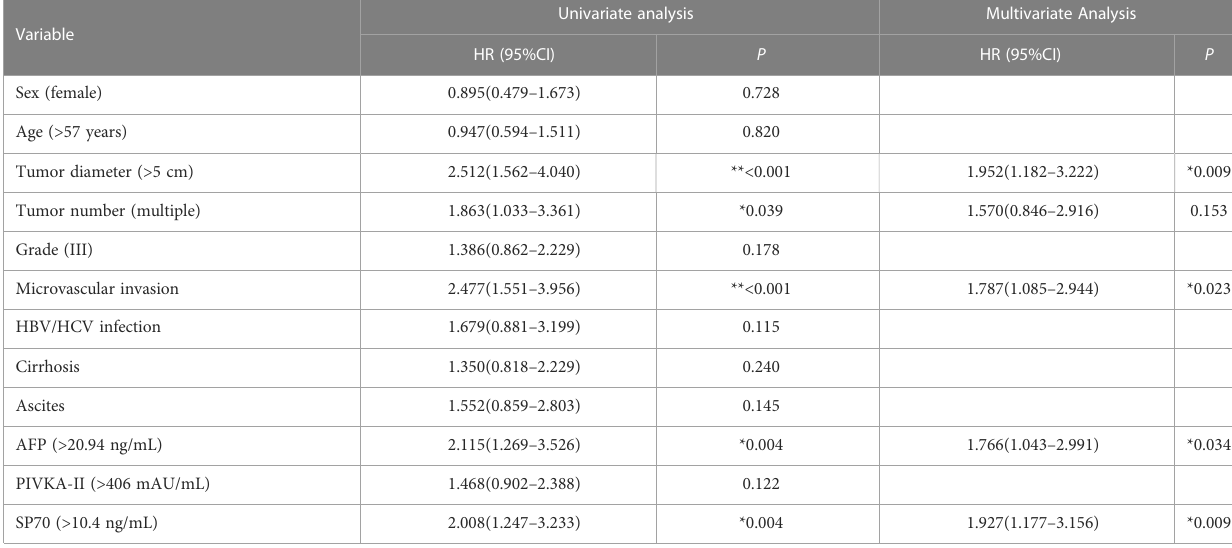
TABLE 4 Univariate and multivariate analysis of risk factors predicting recurrence-free survival after radical hepatectomy in HCC patients. Univariate analysis Multivariate Variable